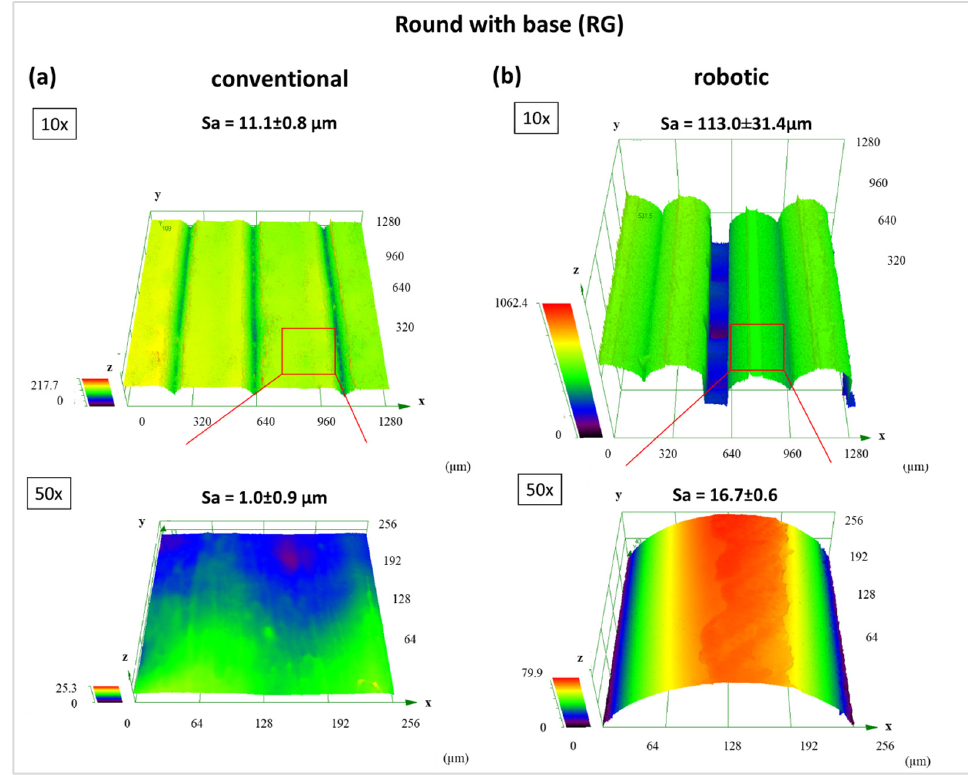
Figure 9. Surface characteristics of “RG”-bottoms determined using CLSM. ( a ) conventional process and ( b ) robotic fused filament fabrication.